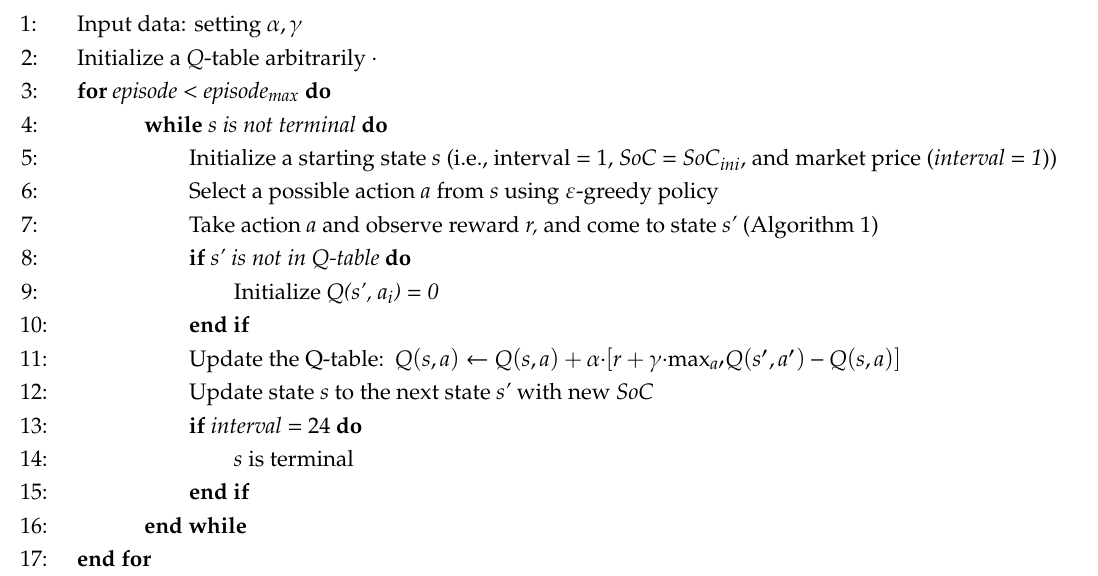
Algorithm 2: Q-Learning-Based Operation Strategy for